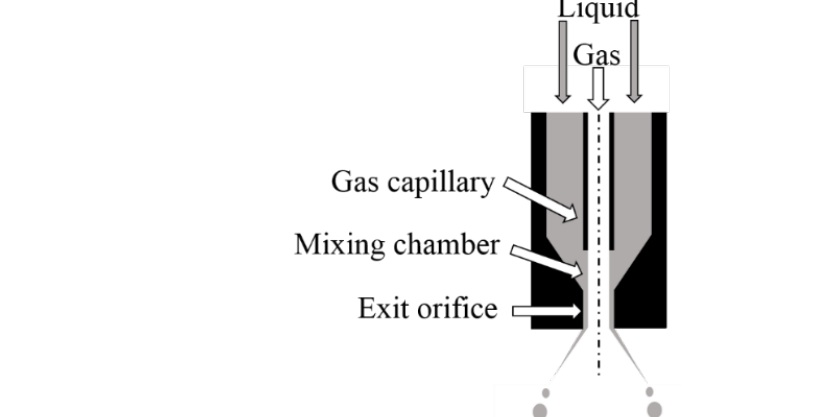
Figure 1. Scheme of the Air-Core-Liquid-Ring (ACLR) atomizer. (d capillary = 1.5 mm; d exit orifice = 1.5 mm; l exit orifice = 1.5 mm; l mixing chamber = 2.4 mm).